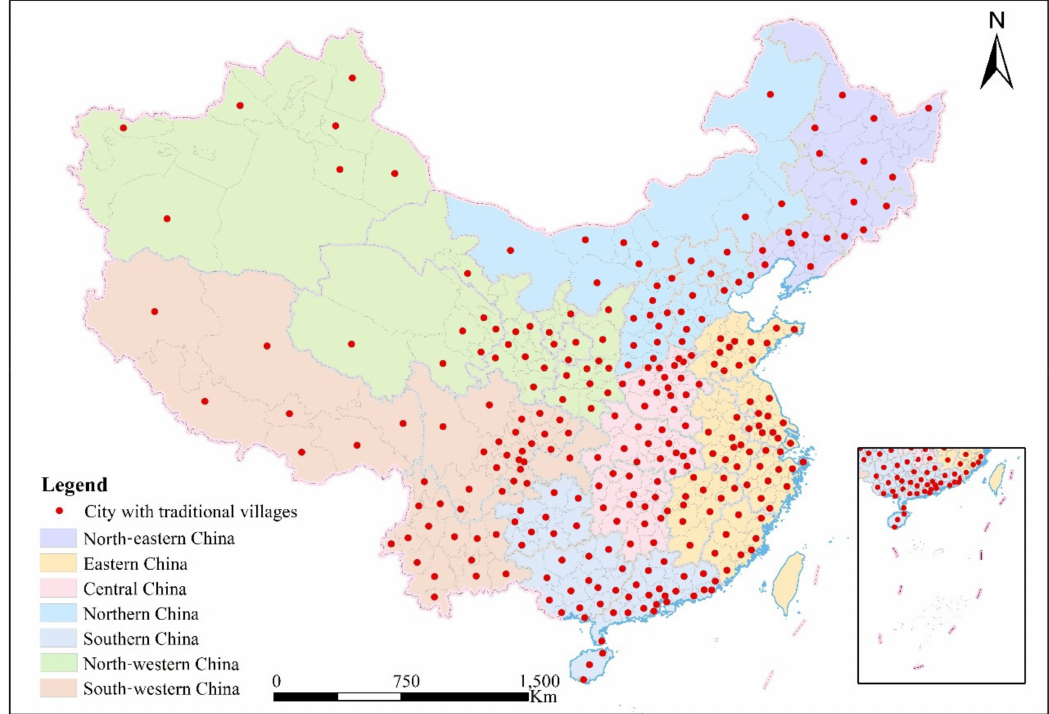
Figure 1. The study area and the distribution of cities with traditional